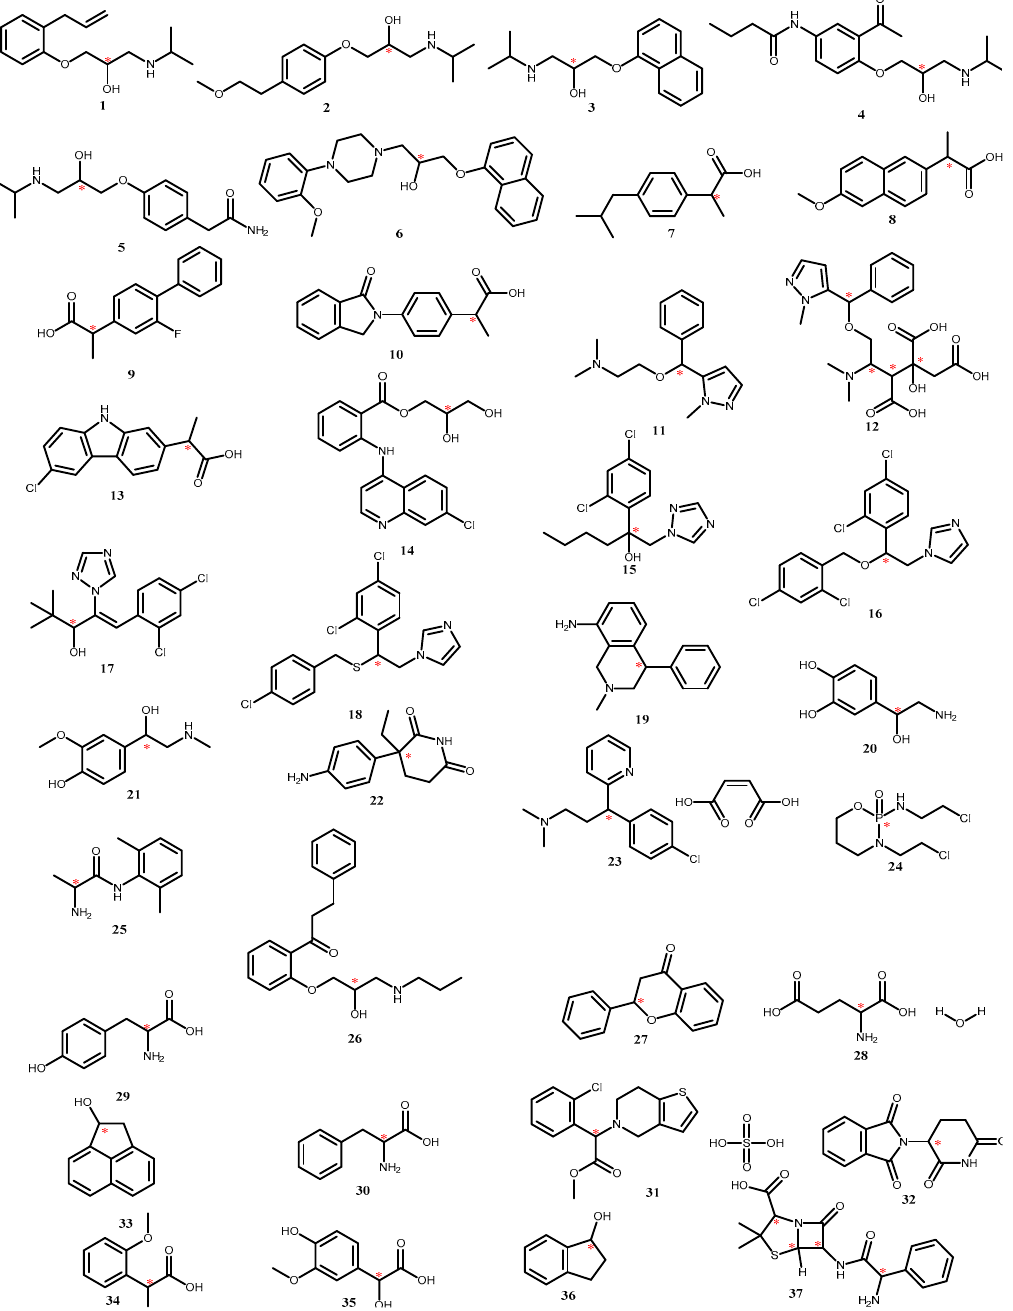
Figure 3. Chemical structures of the investigated racemates.